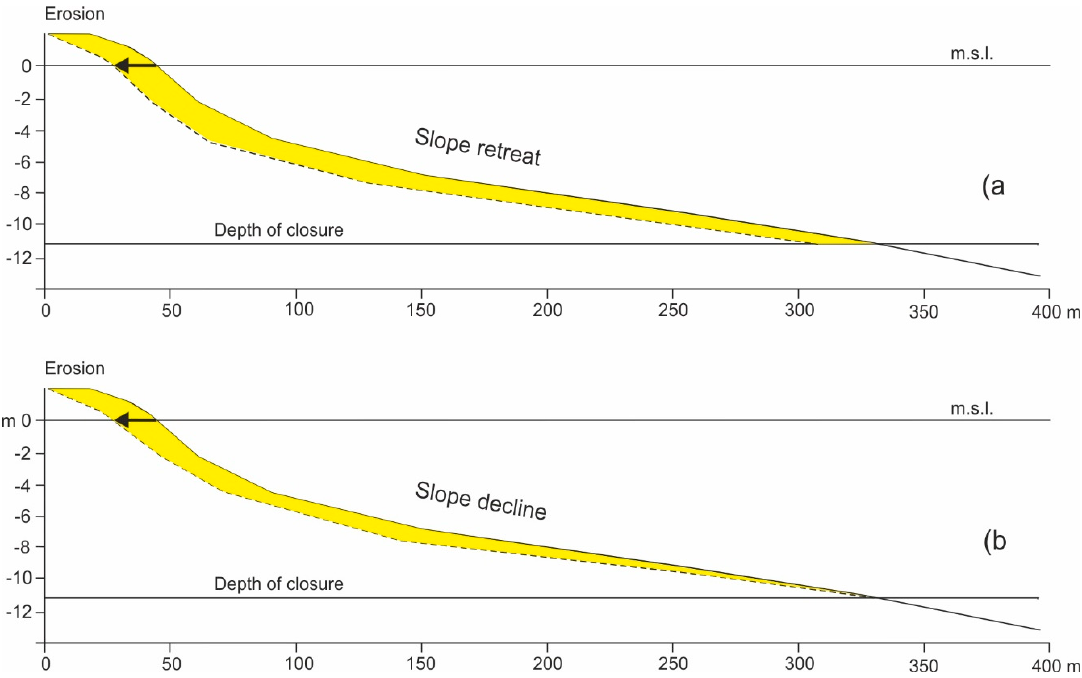
Figure 3. Parallel retreat ( a ) and slope declining ( b ) consequent to a beach sediment